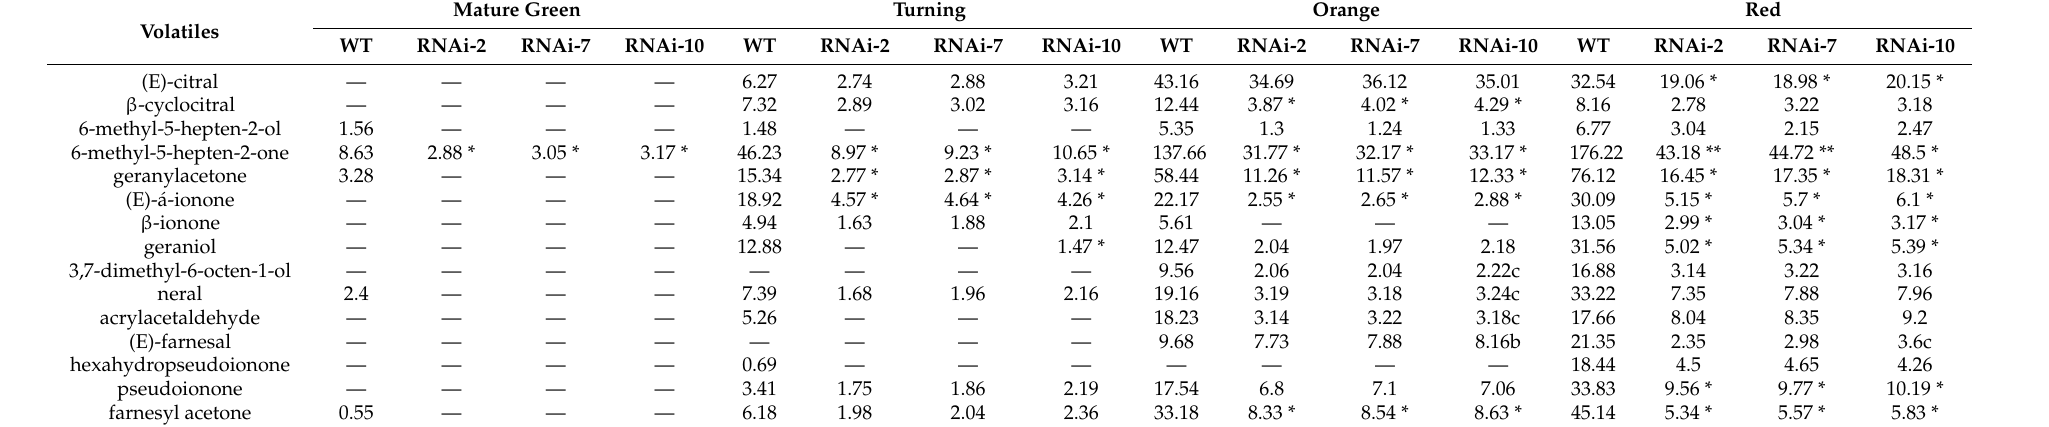
Table 4. RNAi of SlCCD1A on the contents of the carotenoid-derived volatiles in CI1005 tomato fruits ( µ